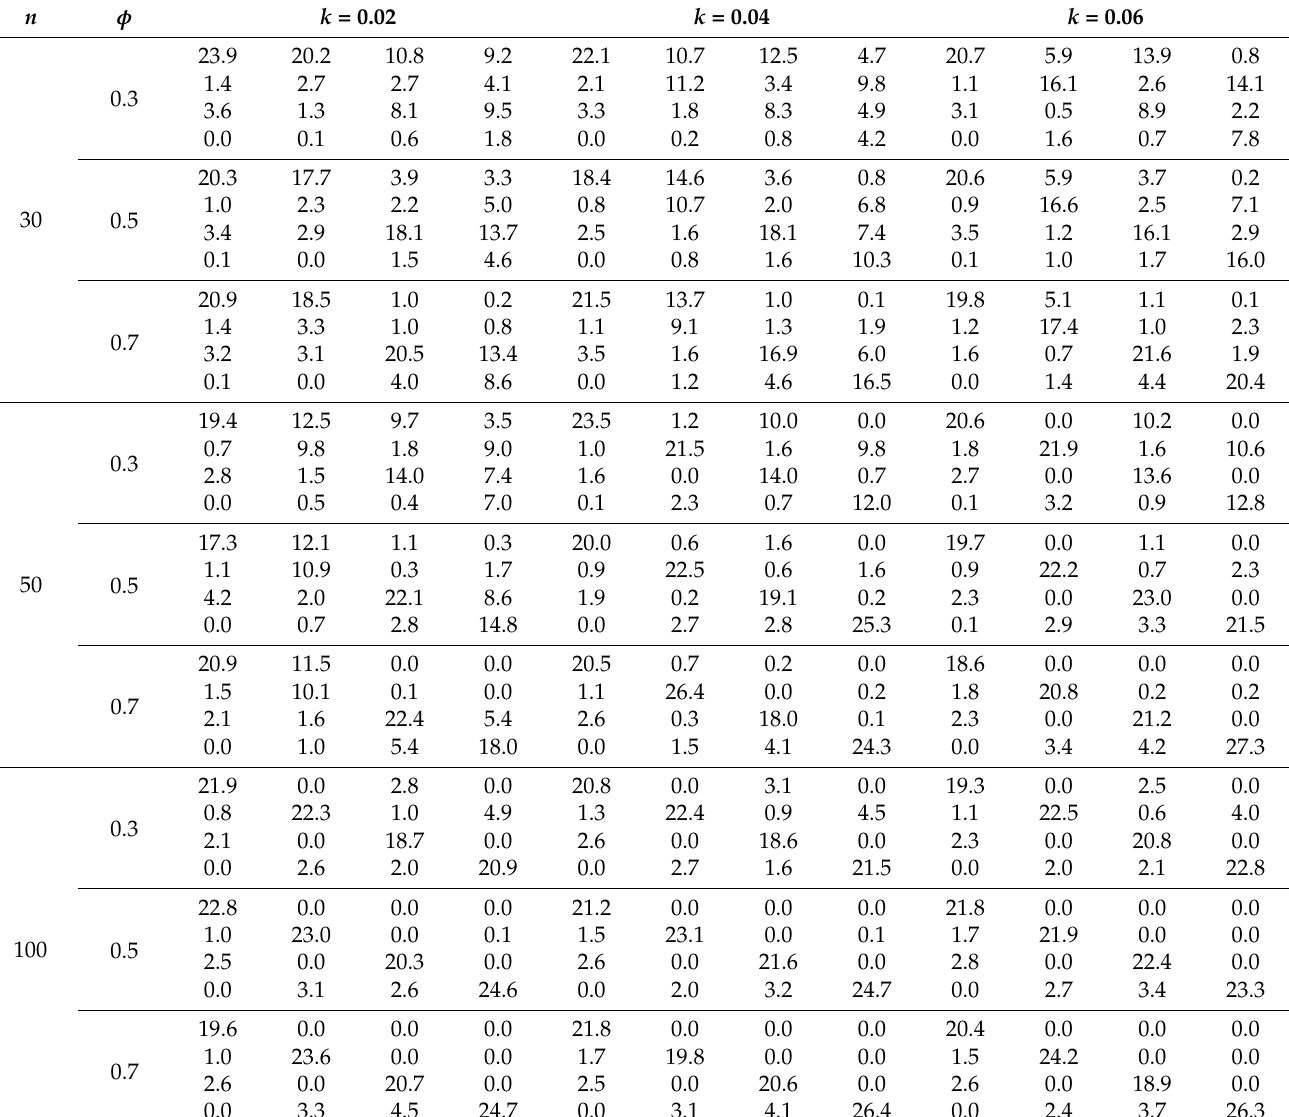
Table A1. SRF matrixes derived by the MMK test in simulation experiment 2 at the 5% significance level. Unit: